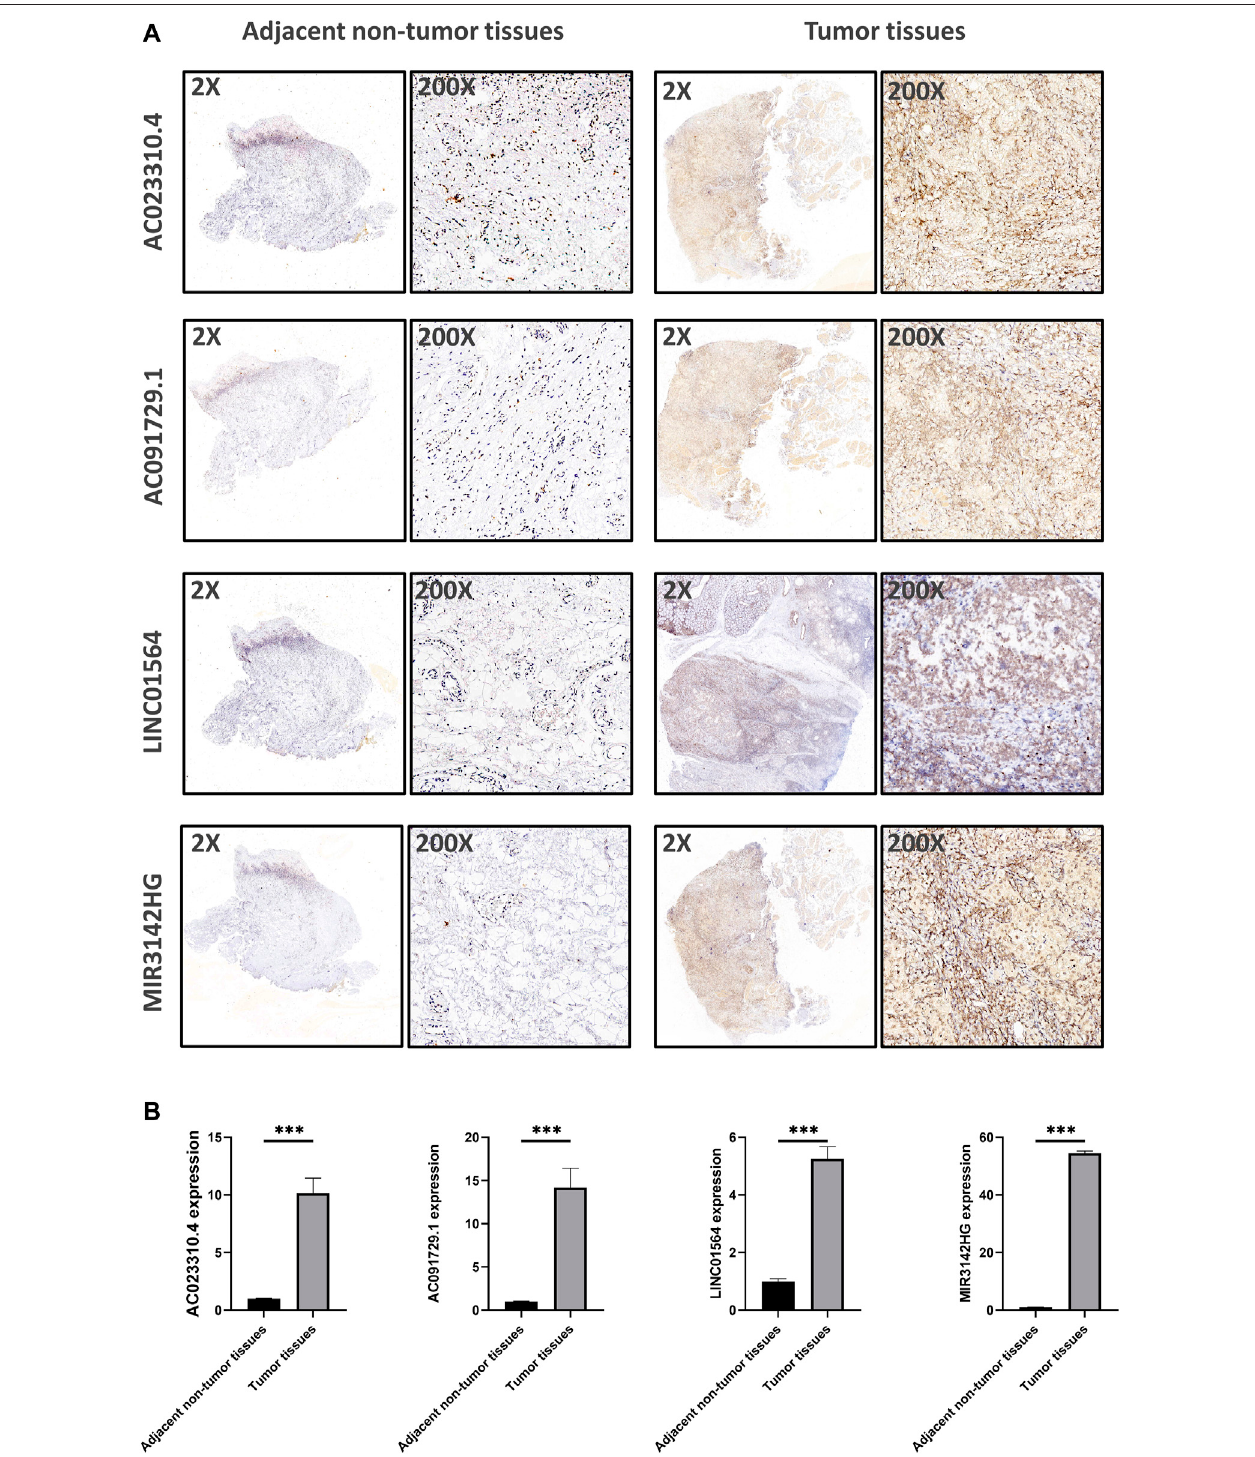
FIGURE 8 | Veri fi cation of the expression levels of the genomic instability-associated lncRNAs signature in clinical samples. (A) Representative images of in situ hybridizationexperimentsinHNSCCpatients.Nucleusstainedwithhematoxylinappearblue,andpositiveexpressionofDABisbrownishyellow. (B) Relativeexpression of the four lncRNAs in HNSCC patients.